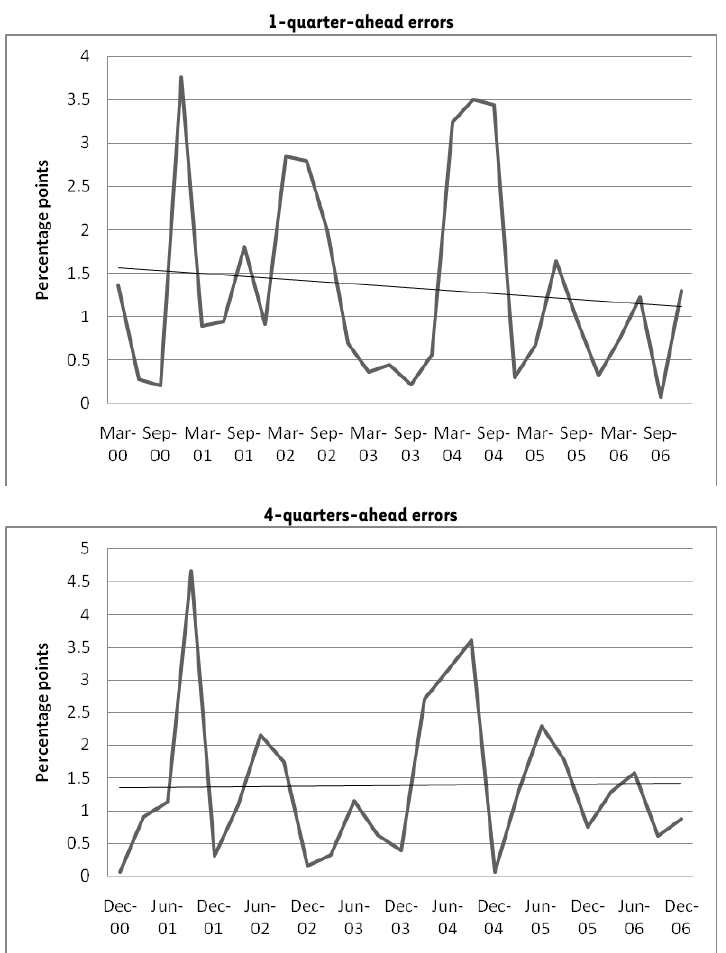
FIGURE 11: GDP forecast errors, 2000-2006